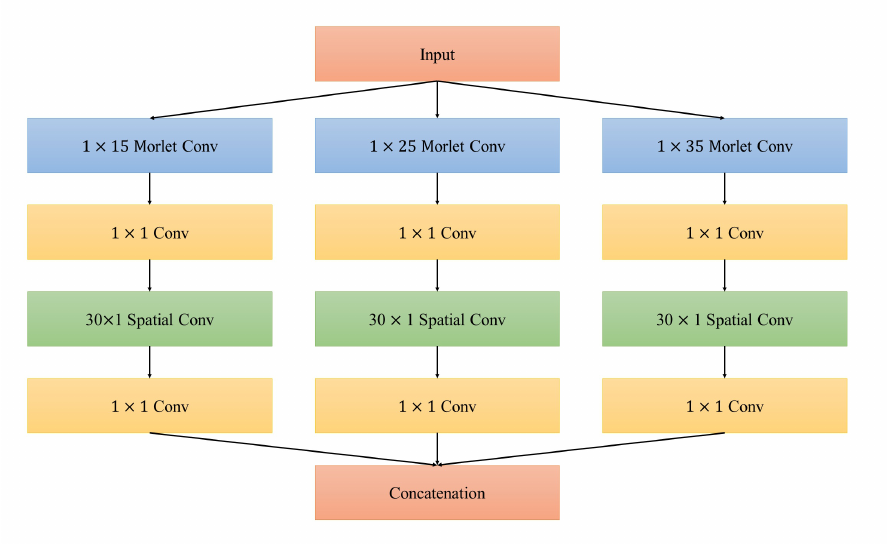
Figure 2. Architecture of inception module in the proposed